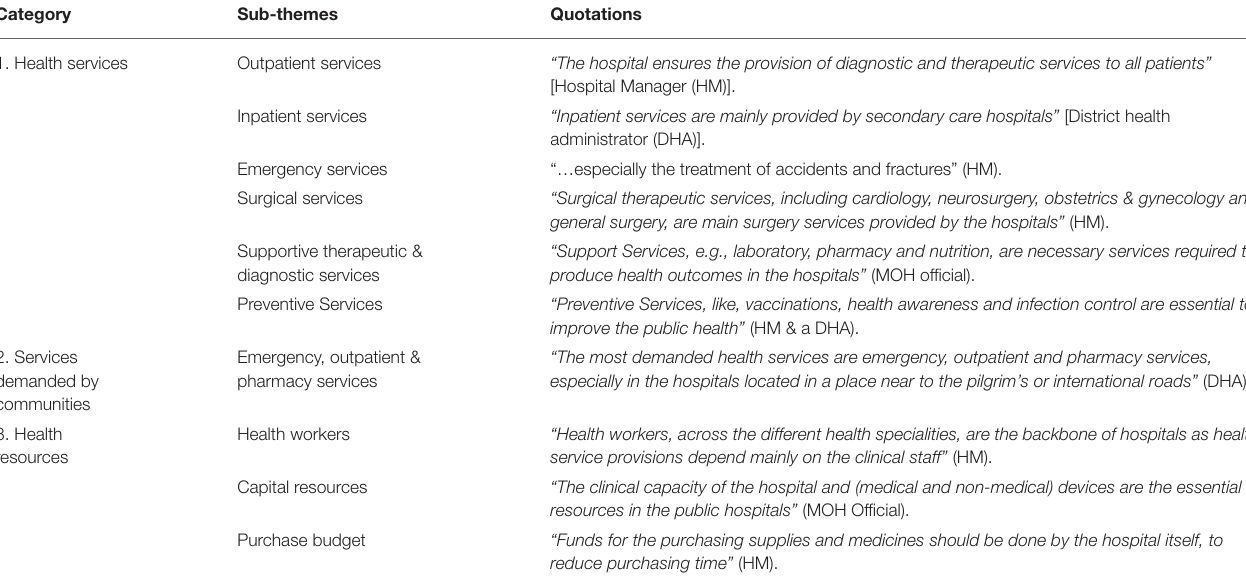
TABLE 2 | Components of performance in the public